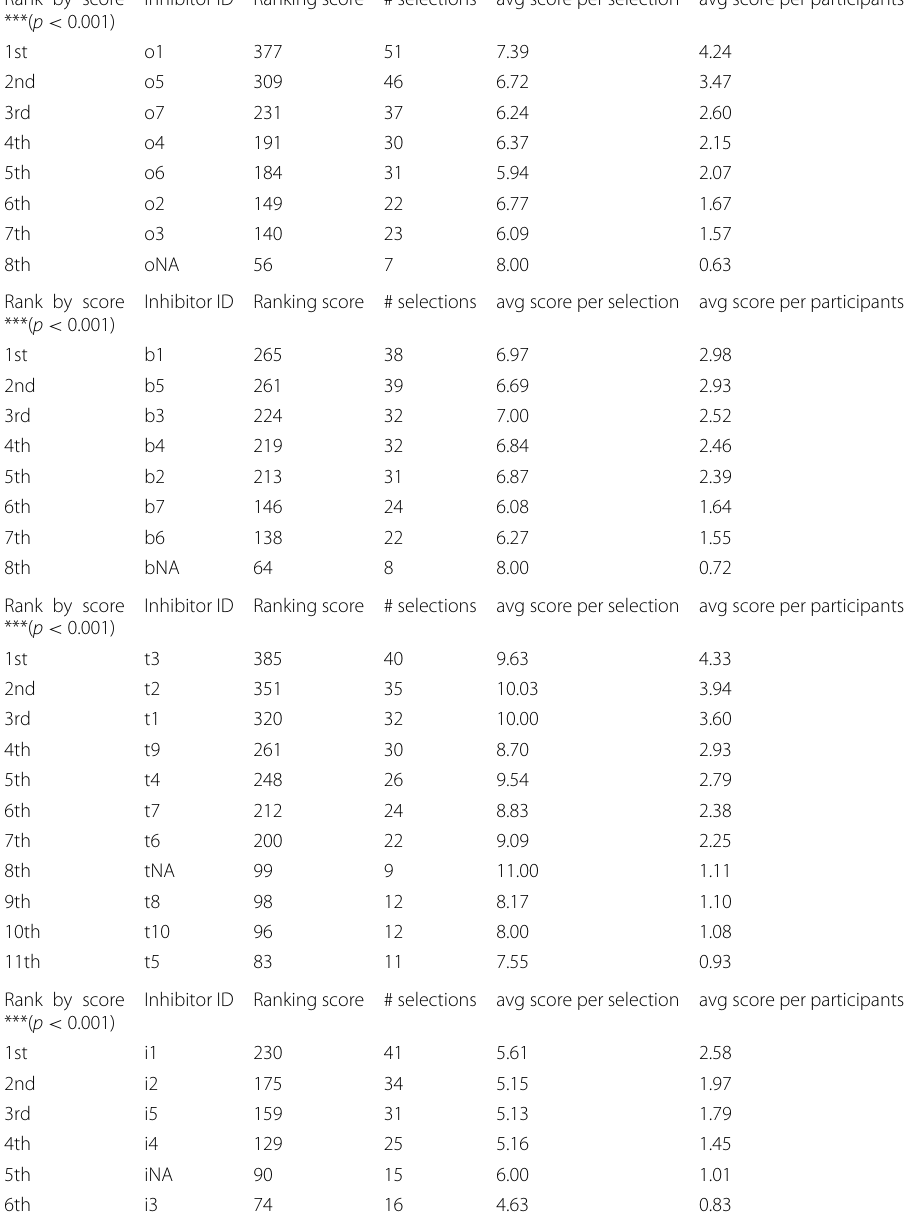
Table 15 Ranking of inhibitors based on ranking scores of all four inhibitor domains ( N = 89) Rank by score ***( p < 0.001)